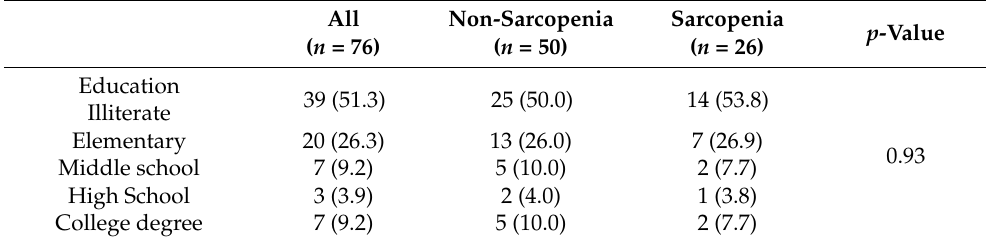
Table 1. Demographic characteristics of participants according to sarcopenia status. All ( n =